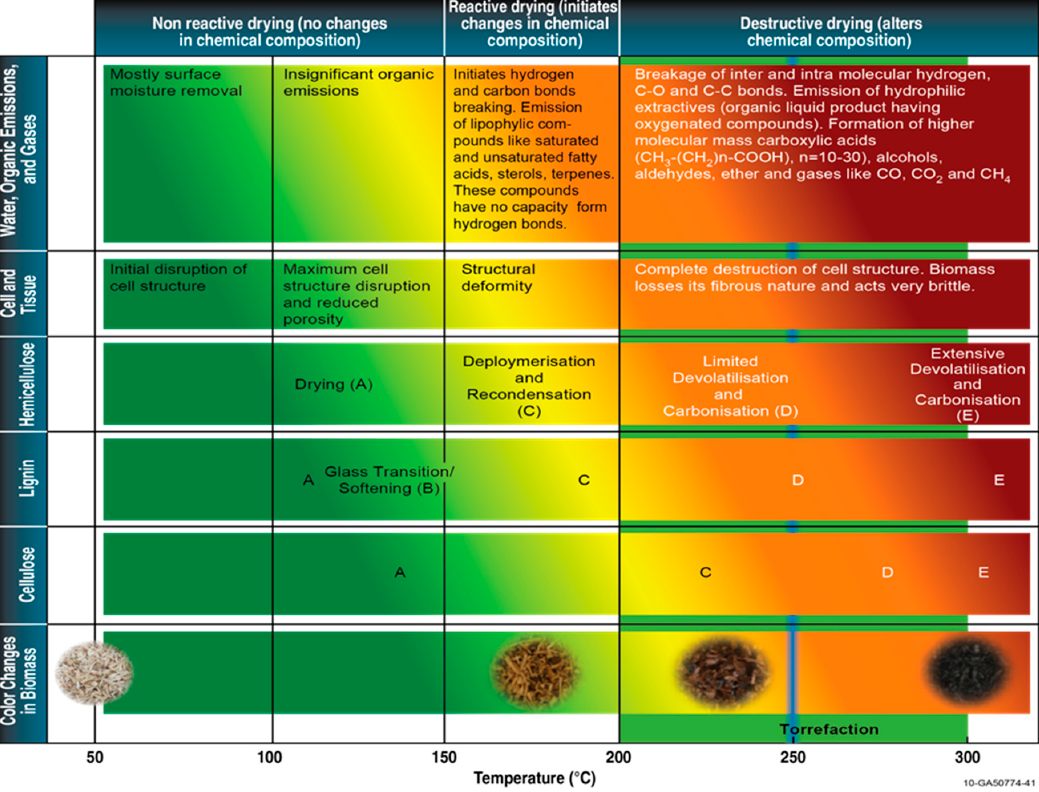
Figure 1. Non-reactive, reactive, and destructive drying temperature impact on the biomass components (adapted from